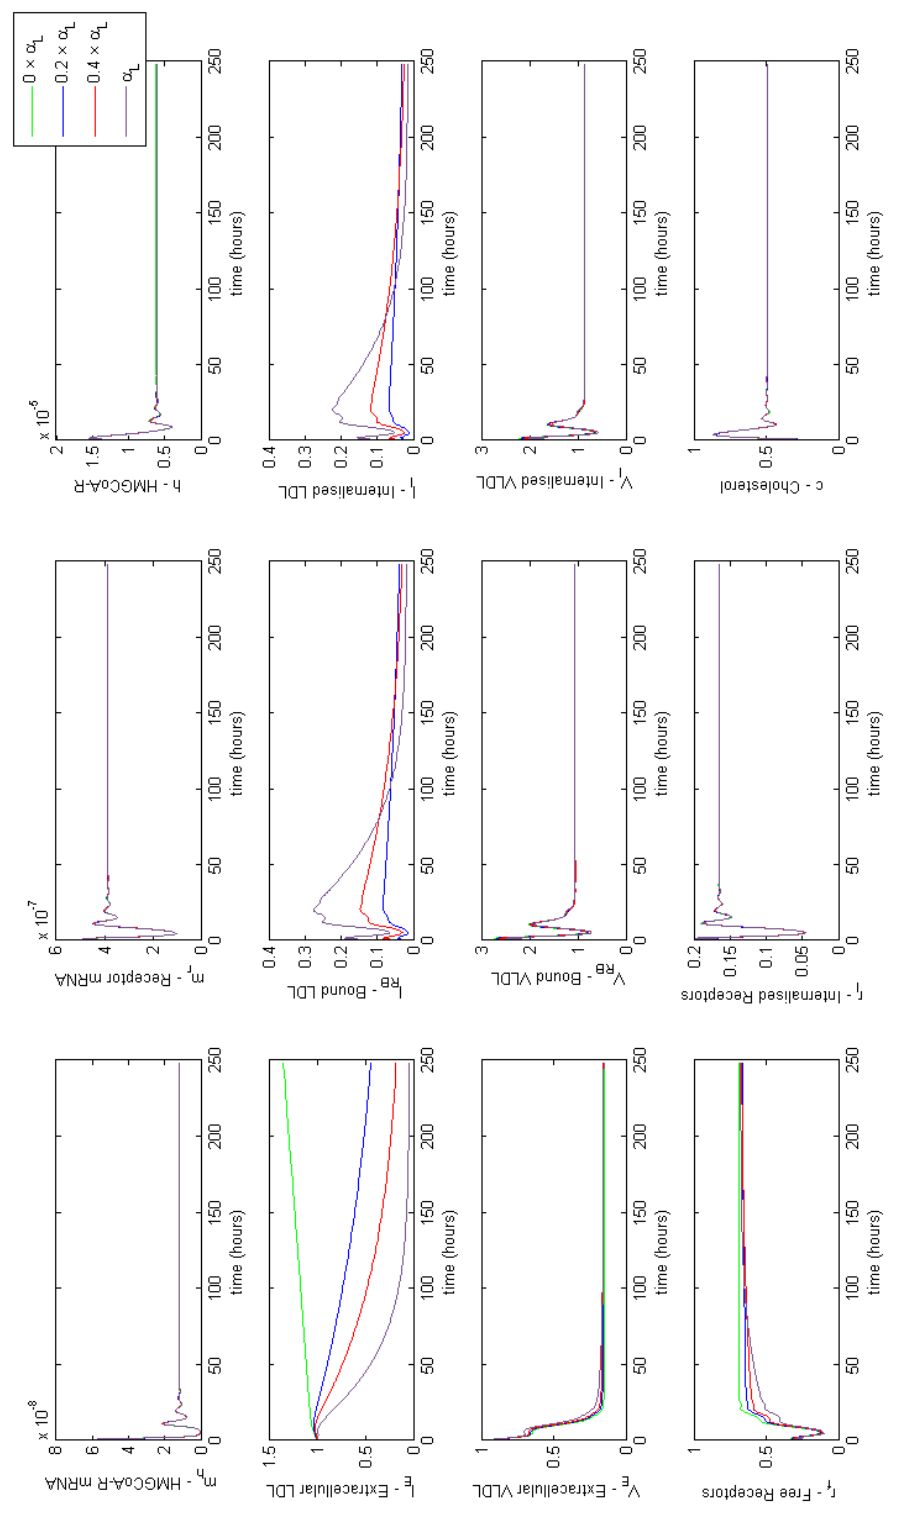
Figure A2. Familial Hypercholesterolaemia Class III; binding of LDL to LDL receptors is ineffective, affecting parameter α L . Results show a lack of LDL binding prevents LDL being